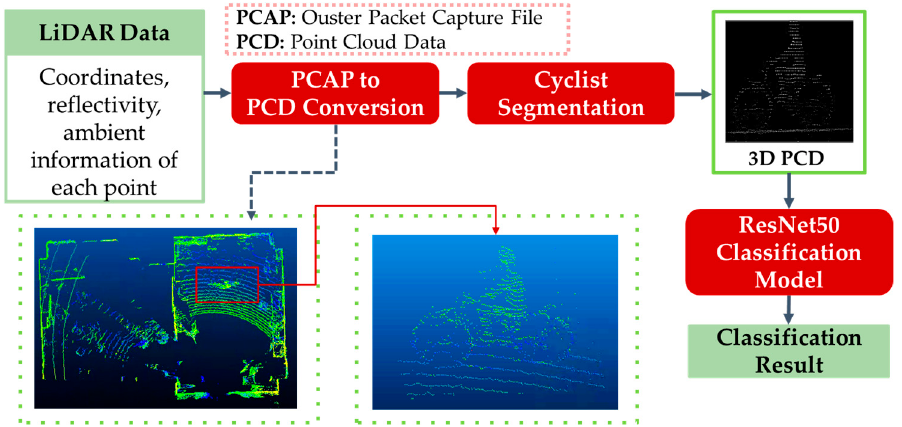
Figure 4. Flowchart of 3D point-cloud-based cyclist orientation estimation.